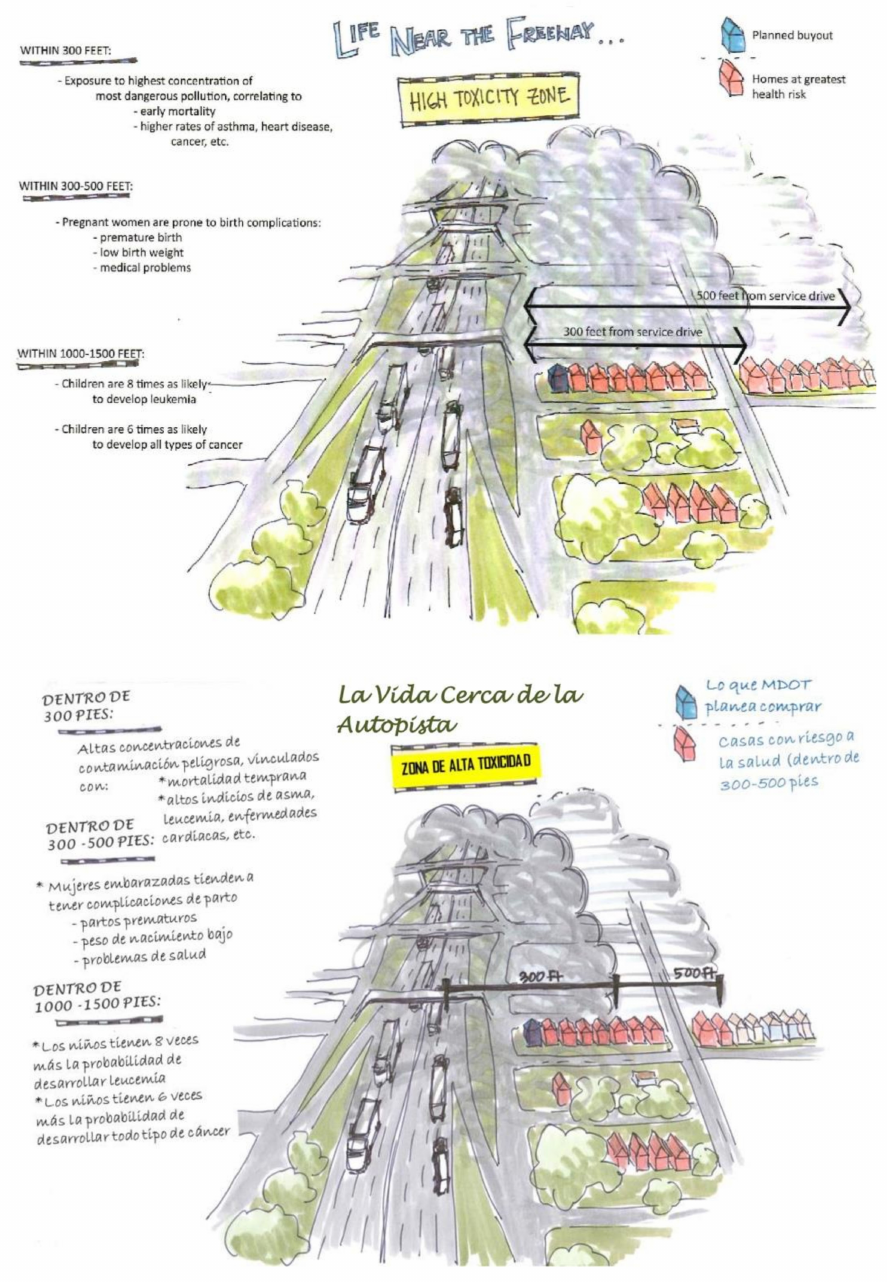
Figure 6. Life near the Freeway Illustration Shared with Survey Participants, English and Spanish (Artist Credit: Sandra Yu Stahl,